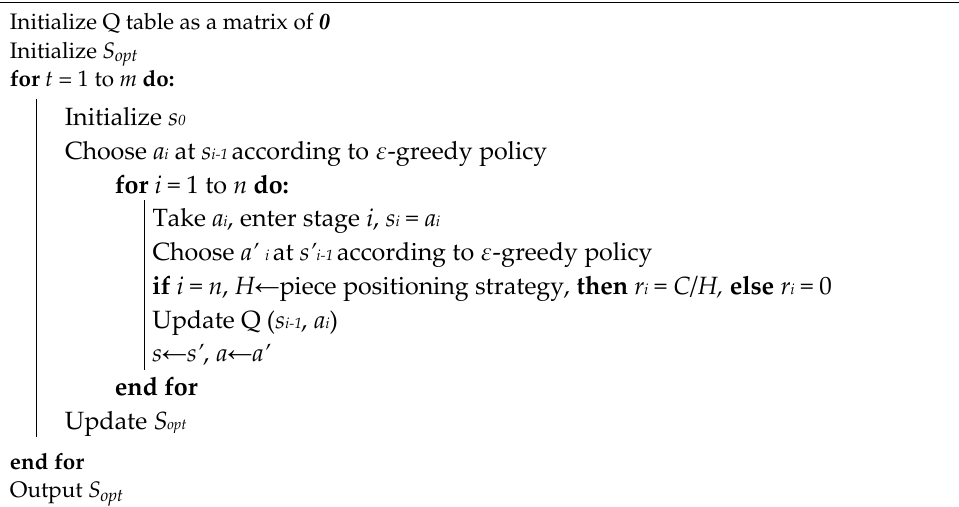
Algorithm 3 Sarsa-learning for a 2D irregular packing problem